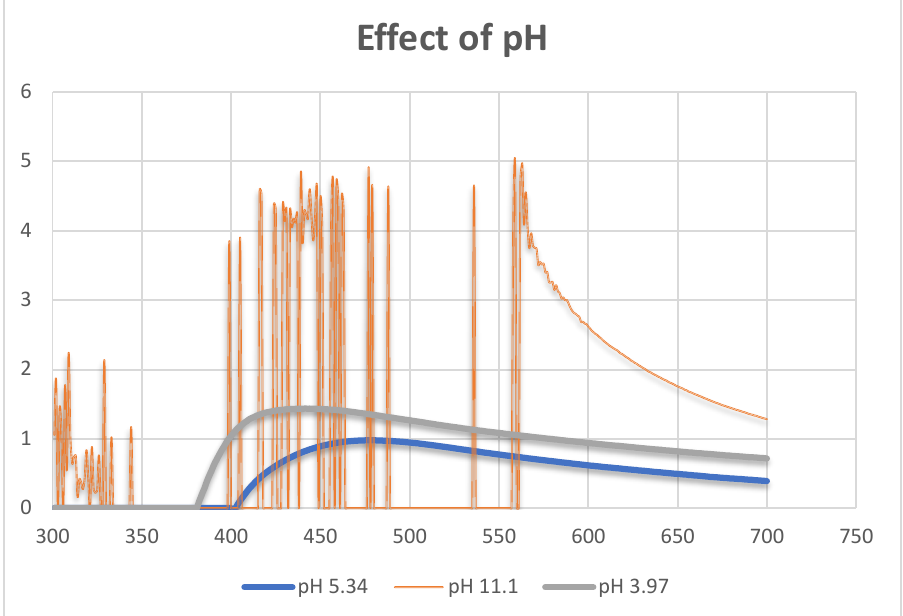
Figure 4. Absorbance spectrum of AgNPs at different pH. For a pH of 3.97, the peak was observed at 435 nm. At a pH of 11.1, a random absorbance pattern is observed.